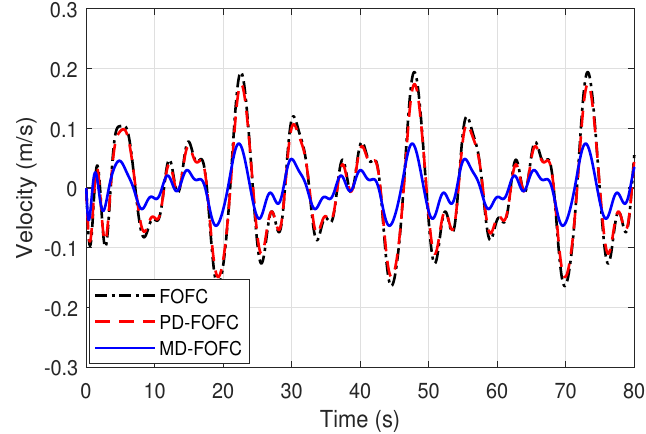
Figure 6. Velocity of the structure with FOFC, PD-FOFC, and MD-FOFC.